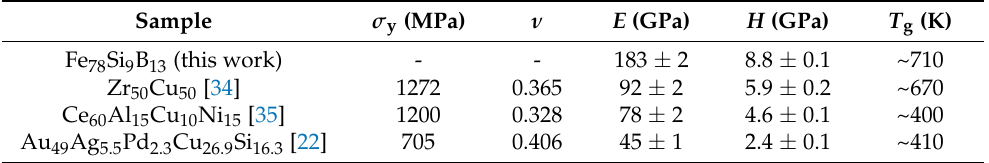
Table 1. Mechanical and physical parameters ( σ y, yield stress; ν , Poisson’s ratio; E , elastic modulus; H , hardness; T g , glass transition temperature) of the four metallic